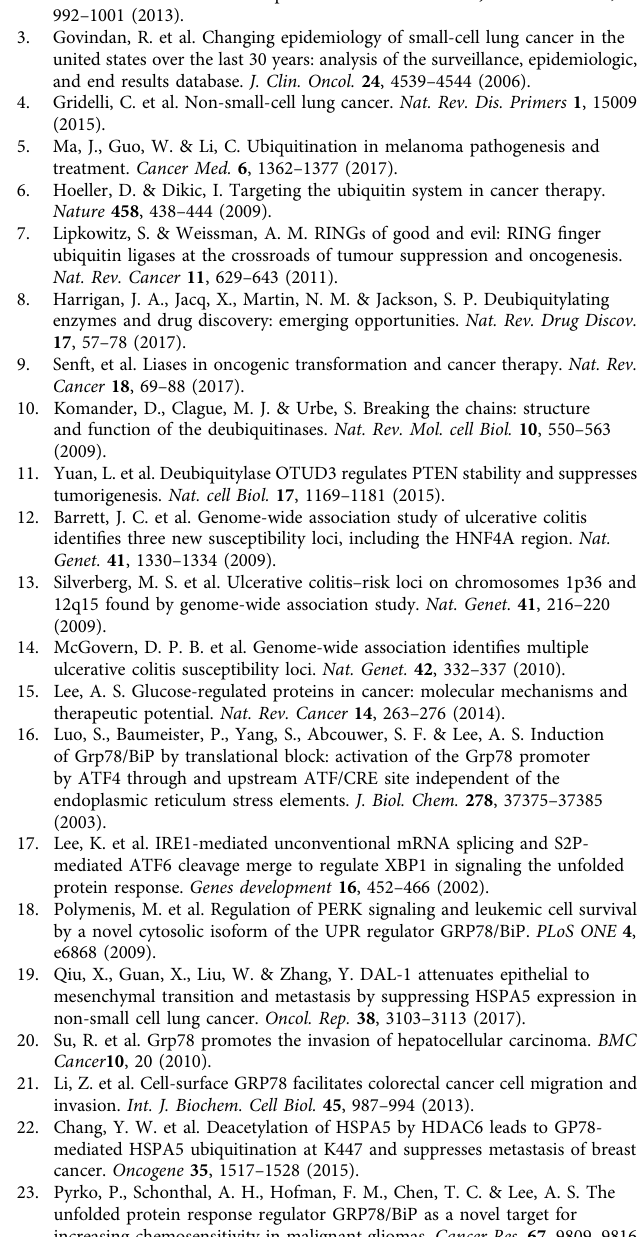
Fig. 7 OTUD3 promotes lung cancer cell growth and migration via GRP78. a , b , e GRP78 was knocked down in OTUD3-overexpressing H1299 cells. Cell lysates were analyzed by western blotting using the indicated antibodies ( a ). Cell growth and migration were examined by colony formation (scale bar, 1 cm) ( b ) and transwell assay (scale bar, 100 μ m) ( e ). For b , e , results shown are mean ± s.d. n = 3 independent experiments. Data were analysed